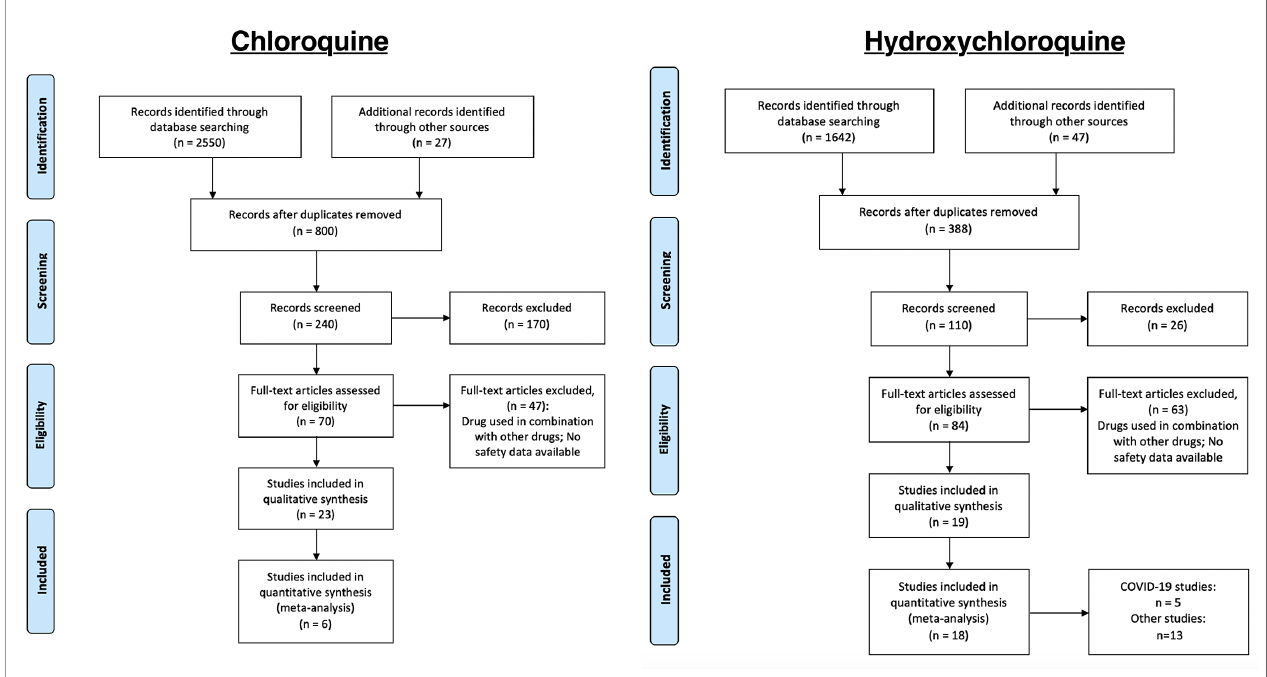
FIGURE 1 | Process of identifying eligible clinical trials. Records were identi fi ed through MEDLINE, CENTRAL, and ClinicalTrials.gov. We used the same process of study collection for both CQ and HCQ. We performed an initial screening, followed by a more stringent screening using our selection criteria. The studies that remained after all the exclusion were the ones used for data extraction. In total, we identi fi ed 23 and 17 studies for CQ and HCQ, respectively, which are described in, Table 1 and 2 . Of those studies, 6 CQ and 16 HCQ records are controlled RCTs, so we used these studies for our data